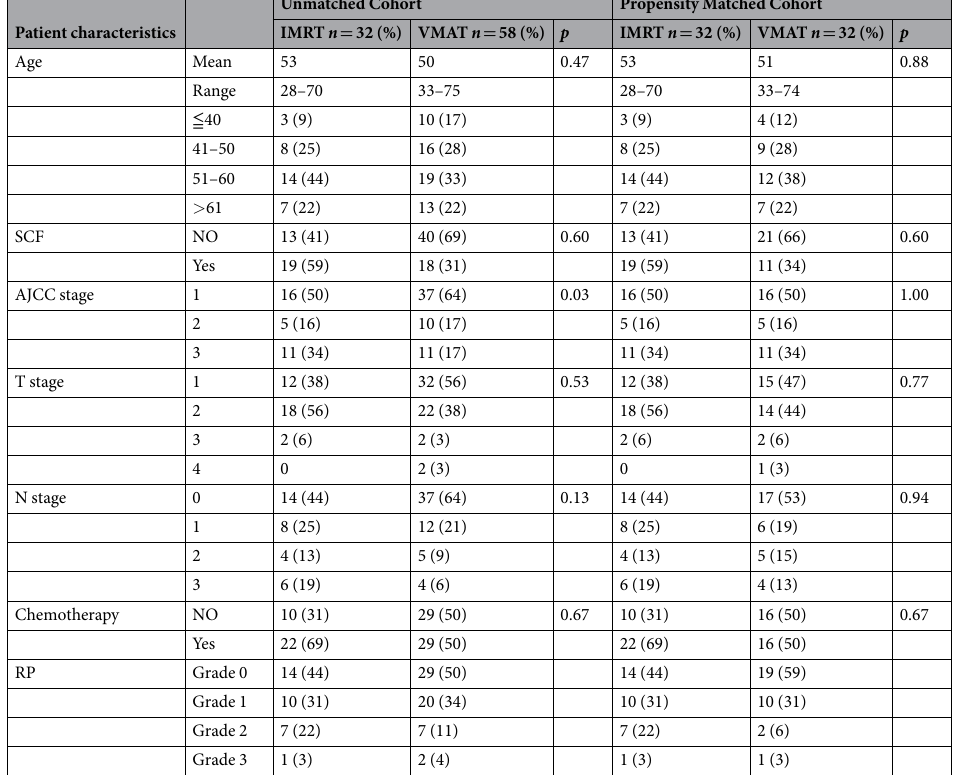
Table 1. Unmatched and propensity score-matched baseline characteristics. Abbreviation : IMRT: intensity modulated radiotherapy; VMAT: volumetric modulated arc therapy; SCF: irradiation to supraclavicular fossa; AJCC American Joint Committee on Cancer; RP: radiation-induced